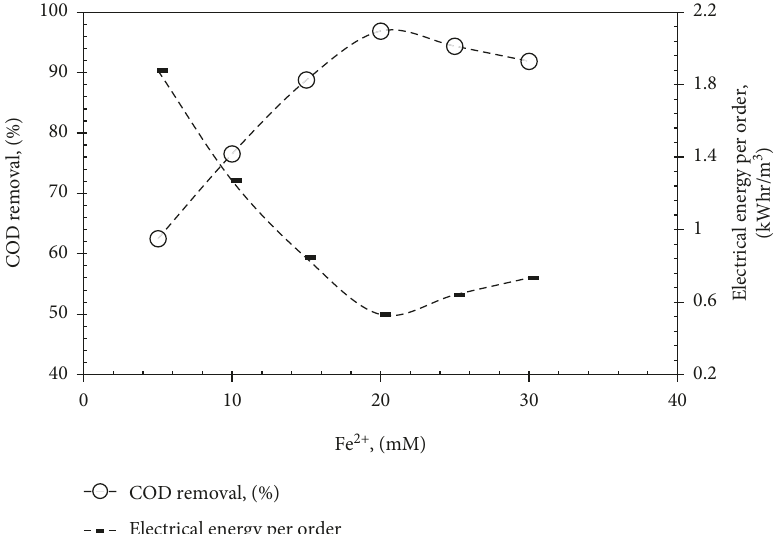
Figure 3: Effect of Fe 2+ on % COD removal and EE/O in the O time–4 h; O 3 flow rate and production–20 LPM and 4g/h; H 2 O 2 –100mM; and